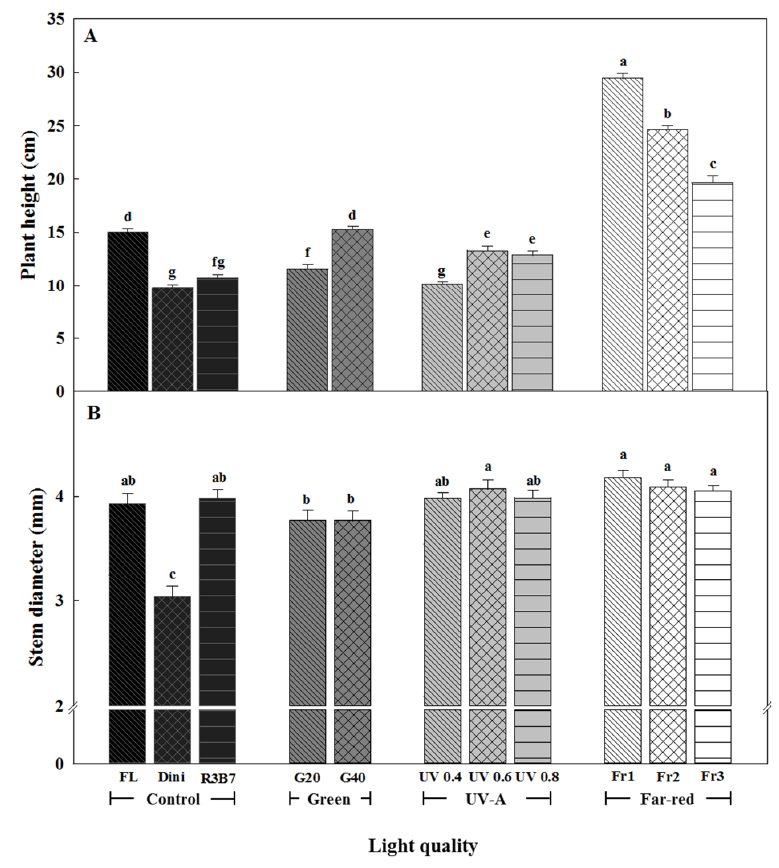
Figure 2. The effects of the light quality on the plant height ( A ) and stem diameter ( B ) of ‘Mini Chal’ tomato ( Solanum lycopersicum L.) measured 21 days after start of treatment. Refer to Figure 1 for details on the light quality. Vertical bars indicate the mean ± standard deviation (SD) ( n = 15). Different letters above bars indicate significant differences by Duncan’s multiple range test at p = 0.05.